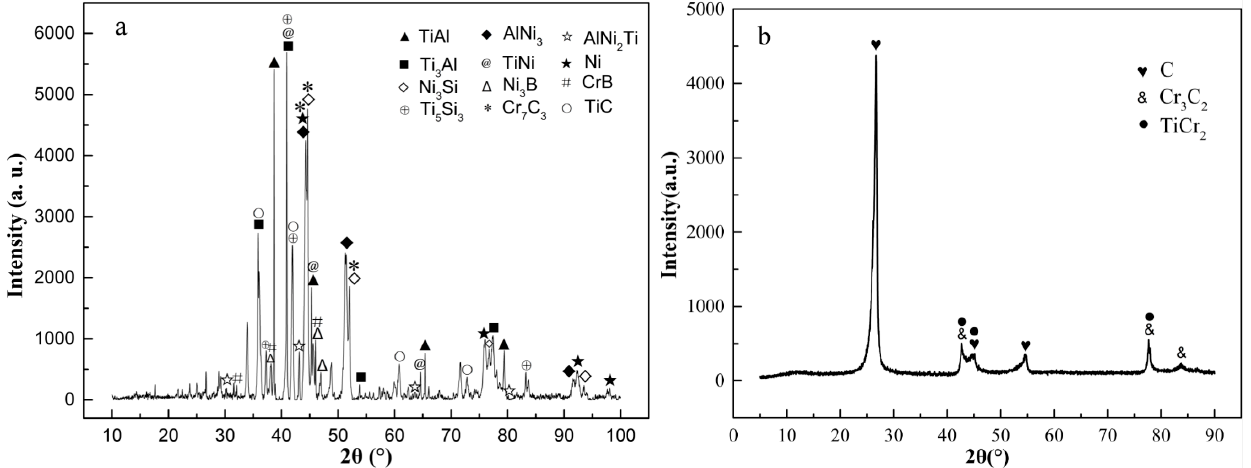
Figure 4. XRD test results of brazed joint under 1060 °C /20 min parameter: ( a) TiAl side, ( b ) C/C composite side [14–28]. The formation of carbides and the relationships between Gibbs free energies ( ∆ G) and temperatures are shown as Equations (2)–(4).